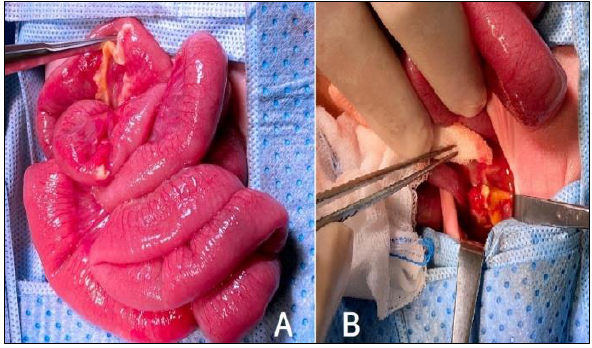
Figure 2: A) Forceps pointing towards area of appendix tip adhesion. B) Acutely inflamed appendix after separation of